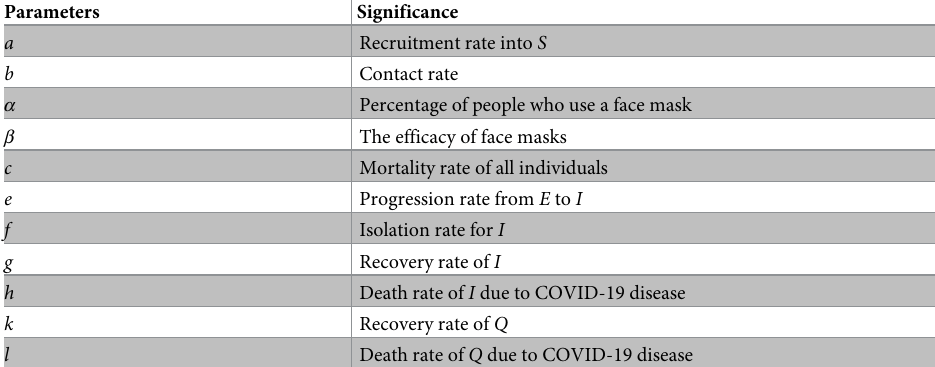
Table 1. Description of the relevant